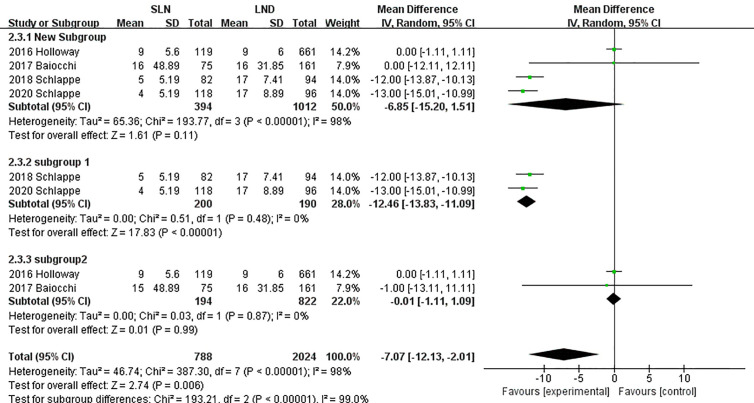
Meta-analysis of para-aortic lymph nodes removed.